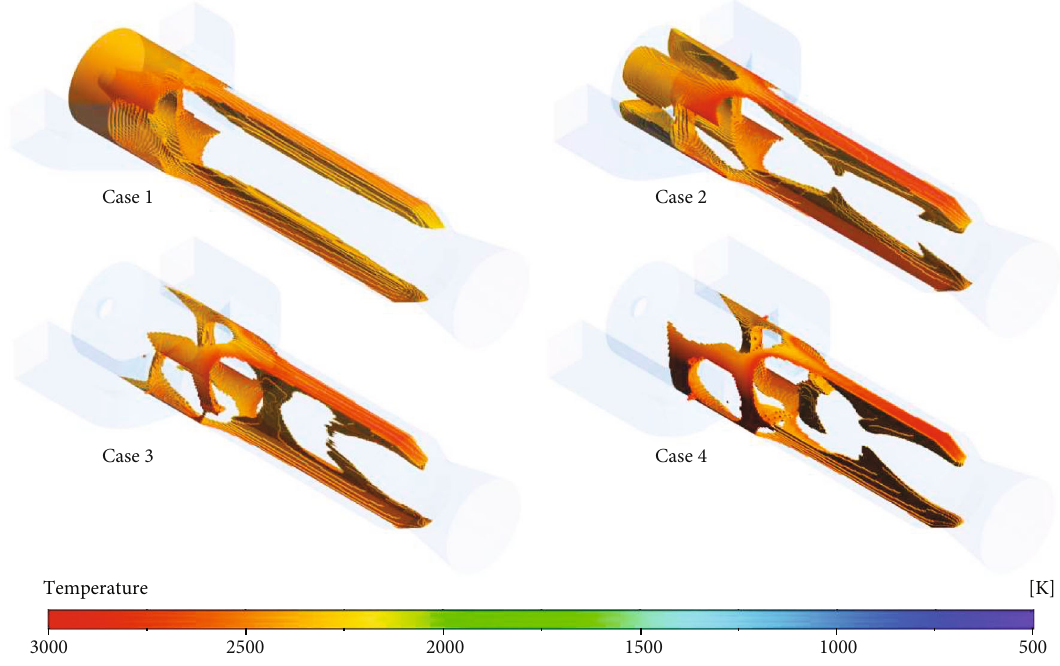
Figure 16: The regions with temperatures greater than 2600K in the